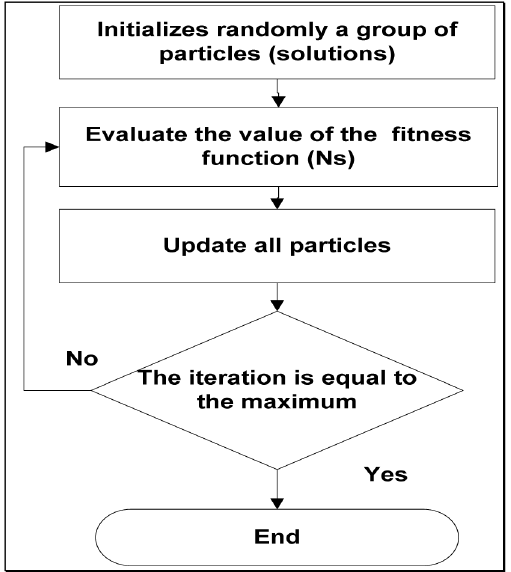
Figure 1. Flowchart of a PSO algorithm.